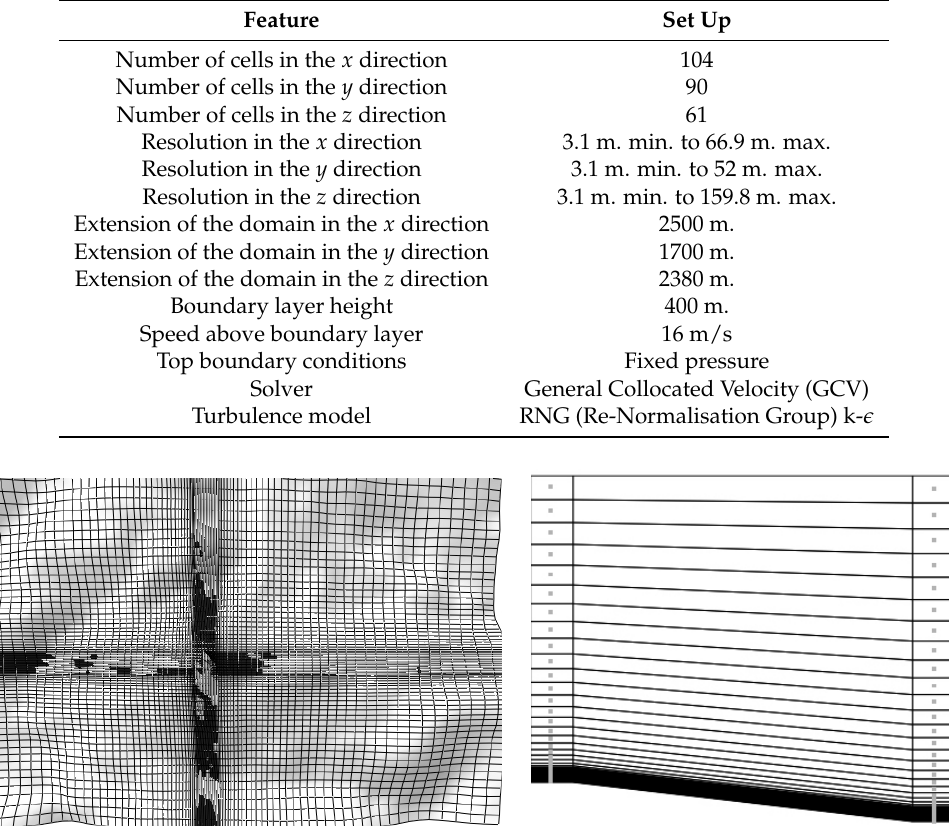
Table 2. The setup of the CFD model.